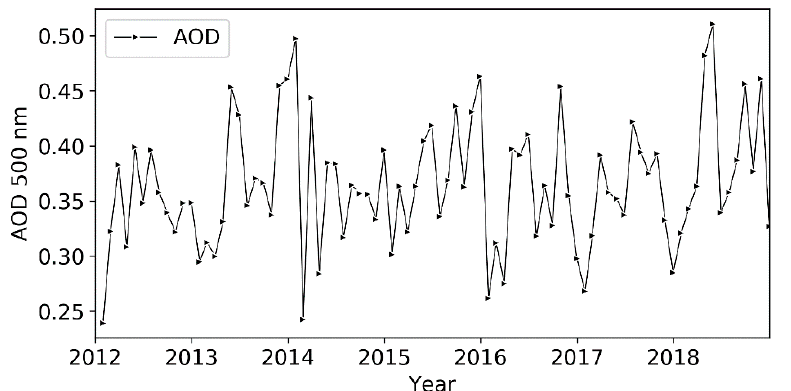
Figure 8. Monthly average AOD (500 nm) from AERONET at the “Cairo EMA-2” station for the period 2012 to 2018.